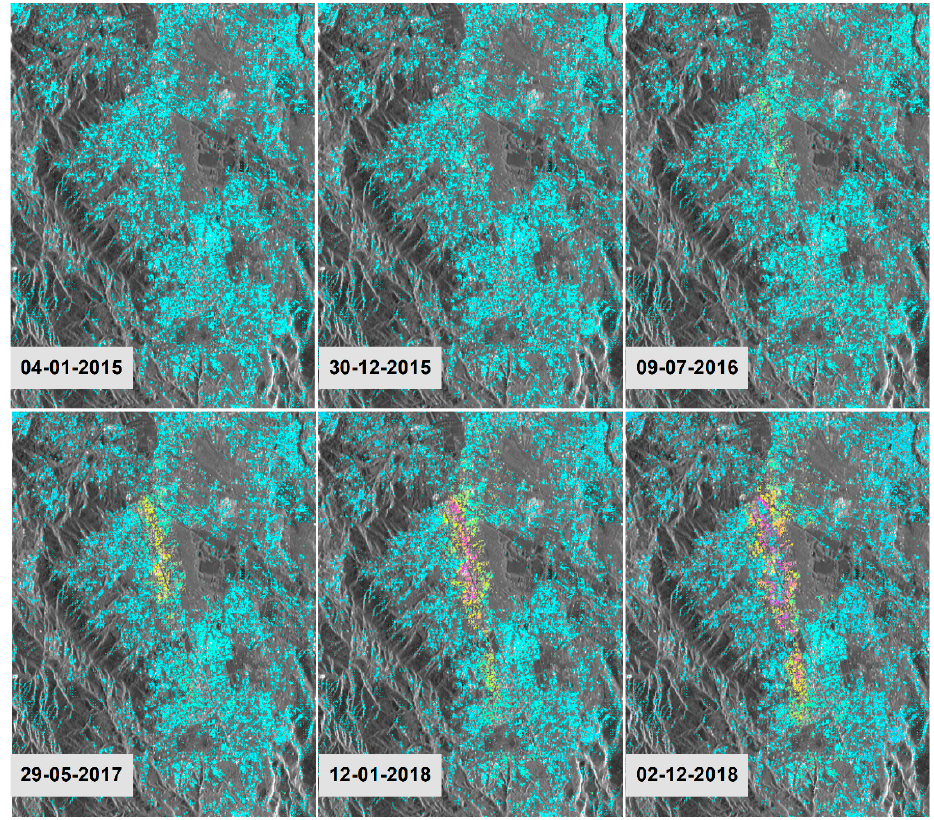
Figure 7. Six different stages of cumulative land subsidence pattern in RADAR geometry. The background image is the averaged intensity image of the study area. One color cycle corresponds to 10 cm/year displacement.